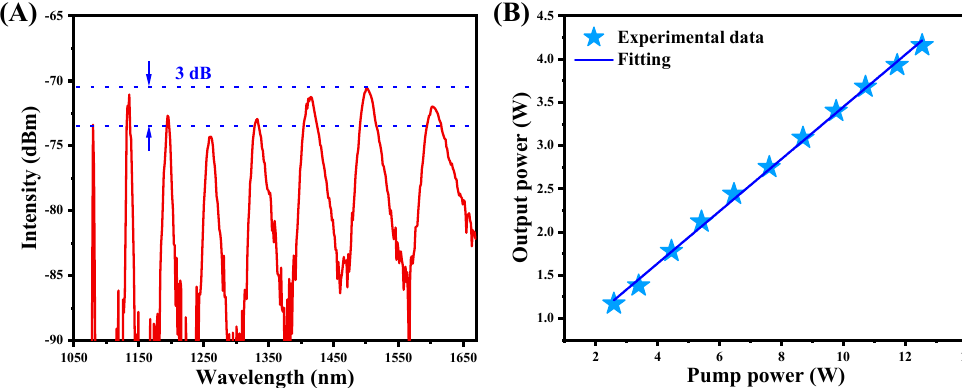
Figure 2. ( A ) Optical spectrum of the multi ‐ wavelength RRFL; ( B ) Total output power of the multi ‐ wavelength RRFL.